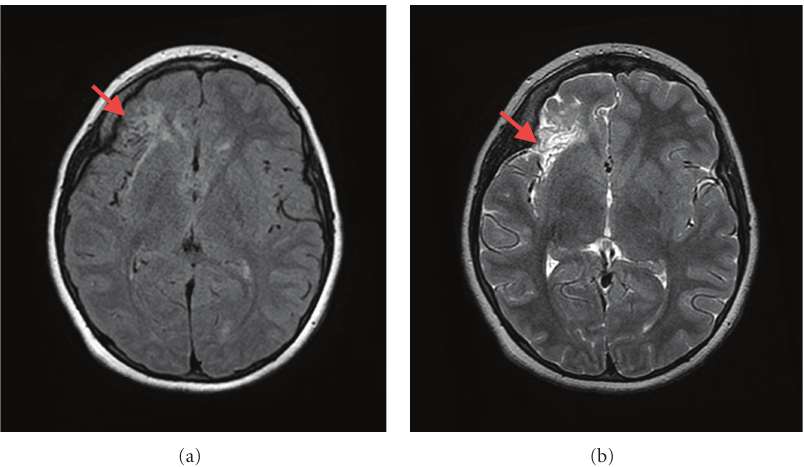
Figure 1: Magnetic resonance imaging studies reveal an abnormality in the right frontal operculum [(a) Axial T2 FRFSE; (b) Axial T2